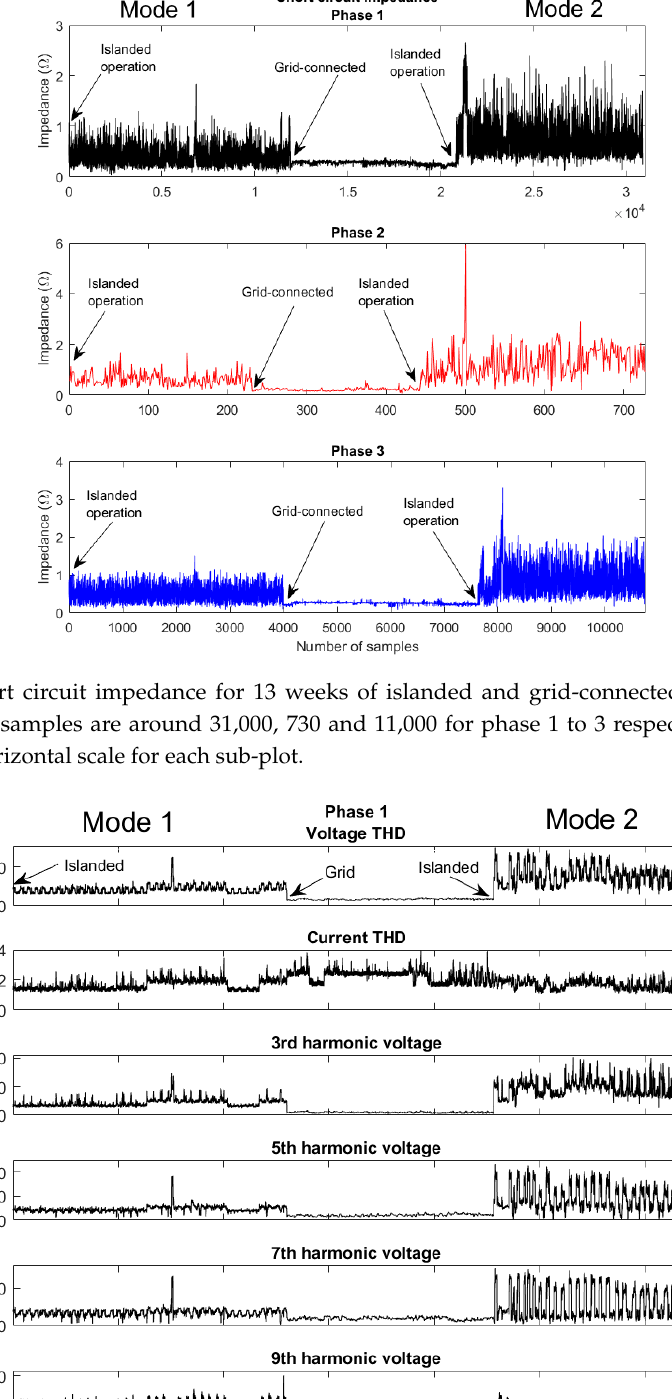
Figure 14. The voltage and current THD, 3rd, 5th, 7th, 9th harmonic voltage and voltage unbalance for phase 1 during a 13 week period in which the samples was extracted for a current rise larger than 4 A within 2 cycles.